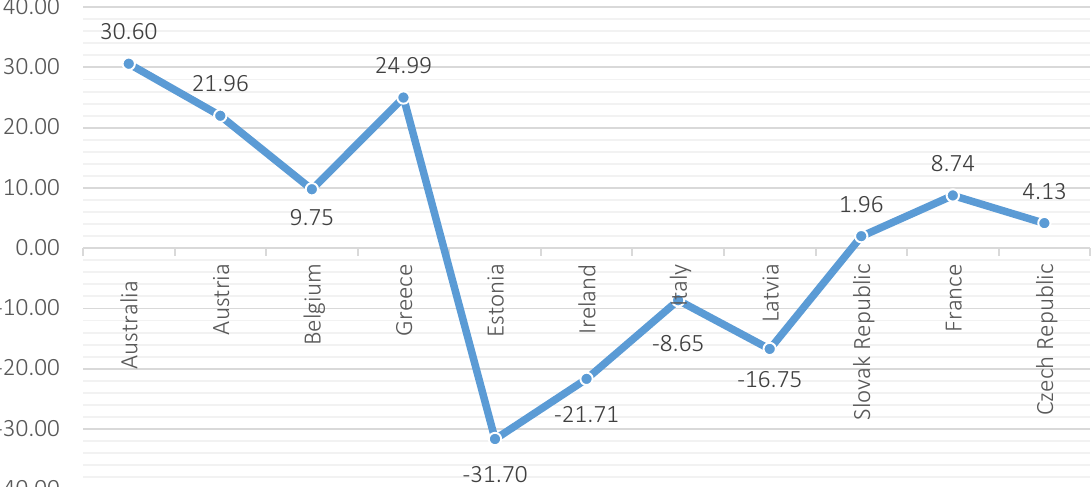
Figure 2. Rates of growth (decrease) in the level of SOLT in 2020 compared to 2010 by individual countries,